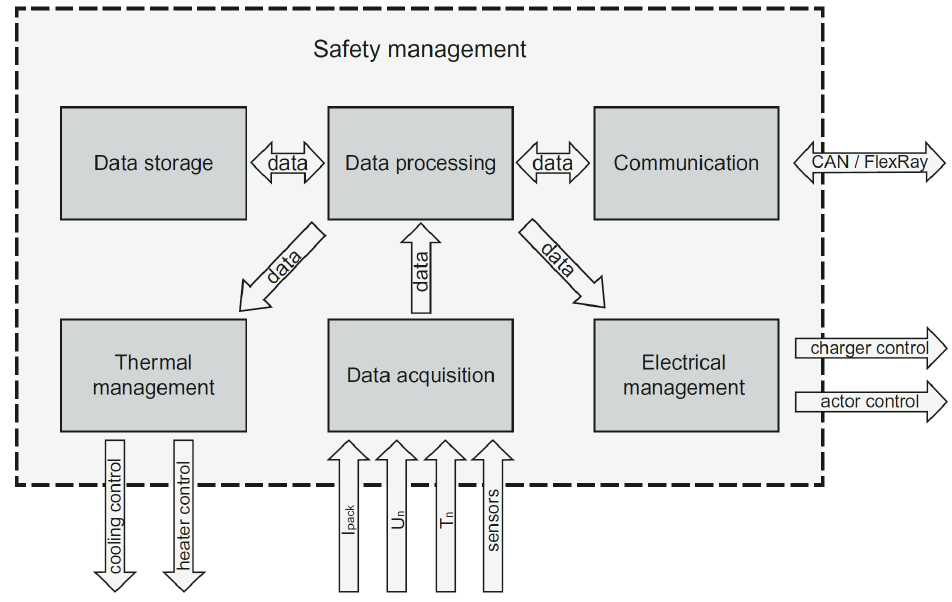
Figure 8. Main components of the Battery Management System (BMS)